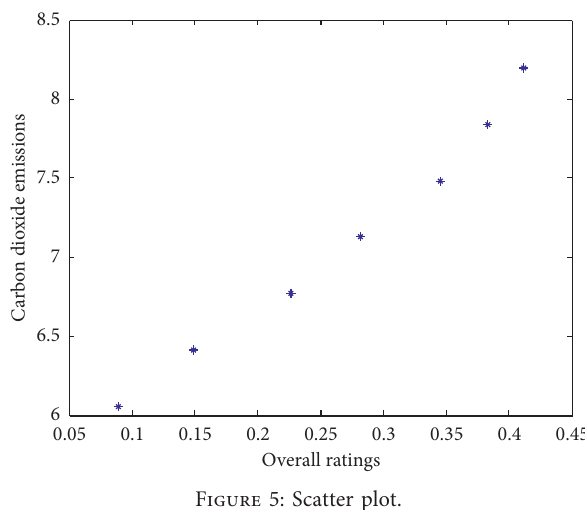
Figure 5: Scatter